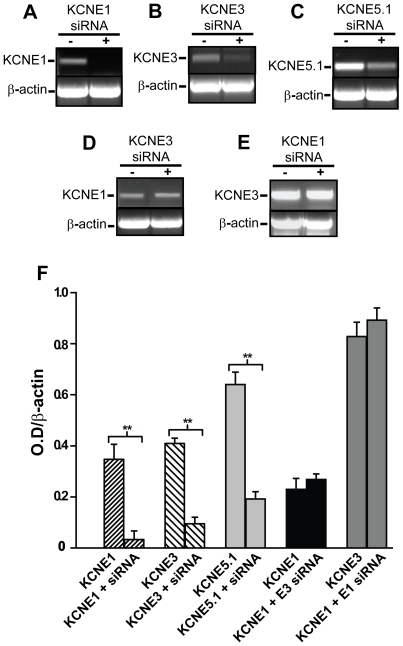
Knockdown of endogenous KCNE expression in Xenopus oocytes with siRNA.(A–E) RT-PCR of xKCNE1, xKCNE3 and xKCNE5.1 mRNA isolated from Xenopus oocytes injected with dH2O (−) or the indicated siRNA (+). RT-PCR for β-actin is shown as a control for normalization of band intensity. (A–C) siRNAs designed against xKCNE1, xKCNE3 and xKCNE5.1 all significantly knock down mRNA expression level of their respective target genes. (D–E) In contrast, siRNA targeted to xKCNE1 and xKCNE3 do not affect mRNA expression levels of other KCNE genes. (F) Optical density of cDNA bands relative to β-actin was quantified using NIH ImageJ. xKCNE1, xKCNE3 and xKCNE5.1 siRNA bands indicted a ∼10-fold, ∼4-fold, and ∼4fold reduction in expression of each respective gene; control injections did not show a significant reduction. Each experiment was performed 3 times; values show Mean±SEM, ** p<0.01.